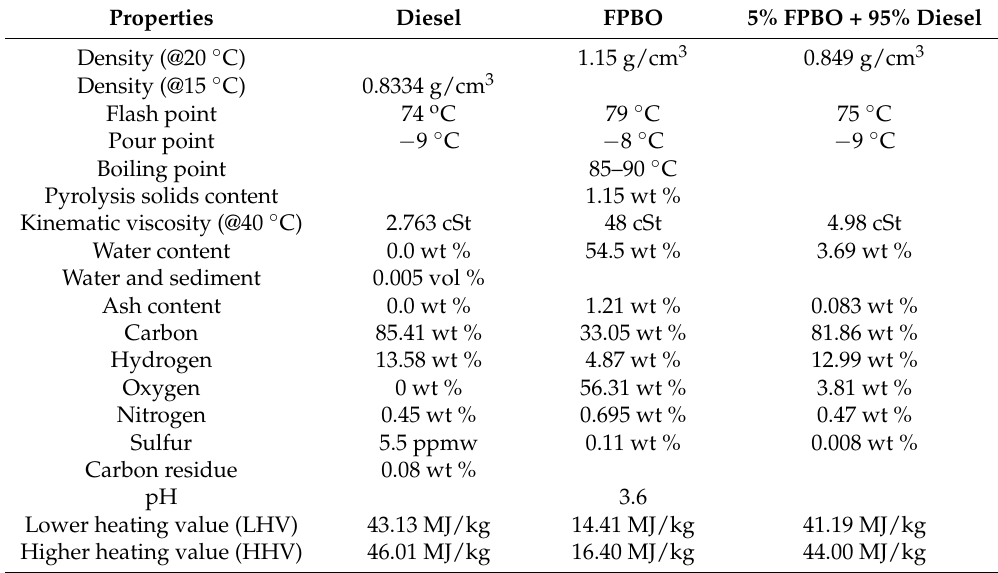
Table 3. Properties of diesel, FPBO (50 vol % oily-phase oil + 50 vol % aqueous-phase oil), and the emulsion of 5% FPBO + 95%